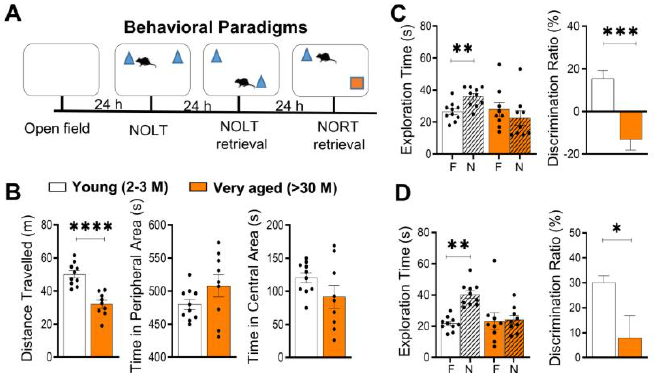
Figure 3. Impaired long-term memory in very aged mice (>30 M-old mice). Long-term memory was tested in >30 M-old mice and 2-3 M-old mice using the novel object location task (NOLT) and novel object recognition task (NORT). ( A ) Timeline for all cognitive tests. ( B ) >30 M-old mice traveled shorter distances compared to 2-3 M-old mice in the open field. Moreover, >30 M-old mice also spent equal time exploring familiar (F) and novel (N) locations and objects, indicating a failure to discriminate between objects in NOLT ( C ) and NORT ( D ). The difference in discrimination between >30 M-old mice and 2-3 M-old mice was further confirmed using discrimination ratio analysis. Bar graphs show mean ± SEM values for each animal. * p < 0.05, ** p < 0.01, *** p < 0.001 and **** p < 0.0001 represent significant differences between 2-3 M-old mice ( n = 10) and >30 M-old mice ( n = 9).